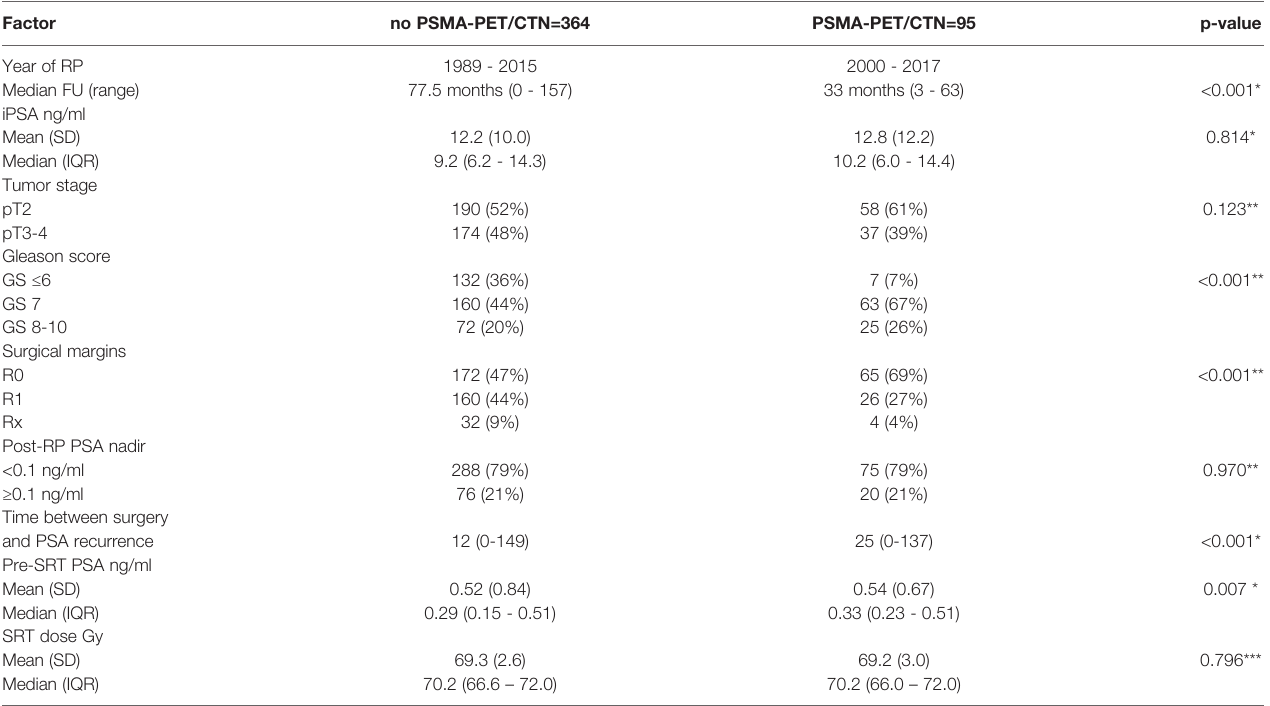
TABLE 1 | Patient